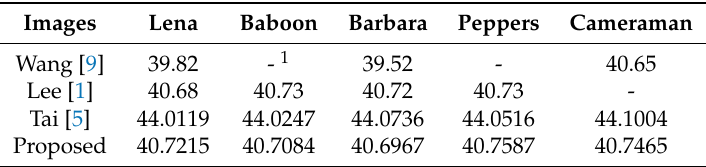
Table 2. The PSNR (dB) of the watermarked